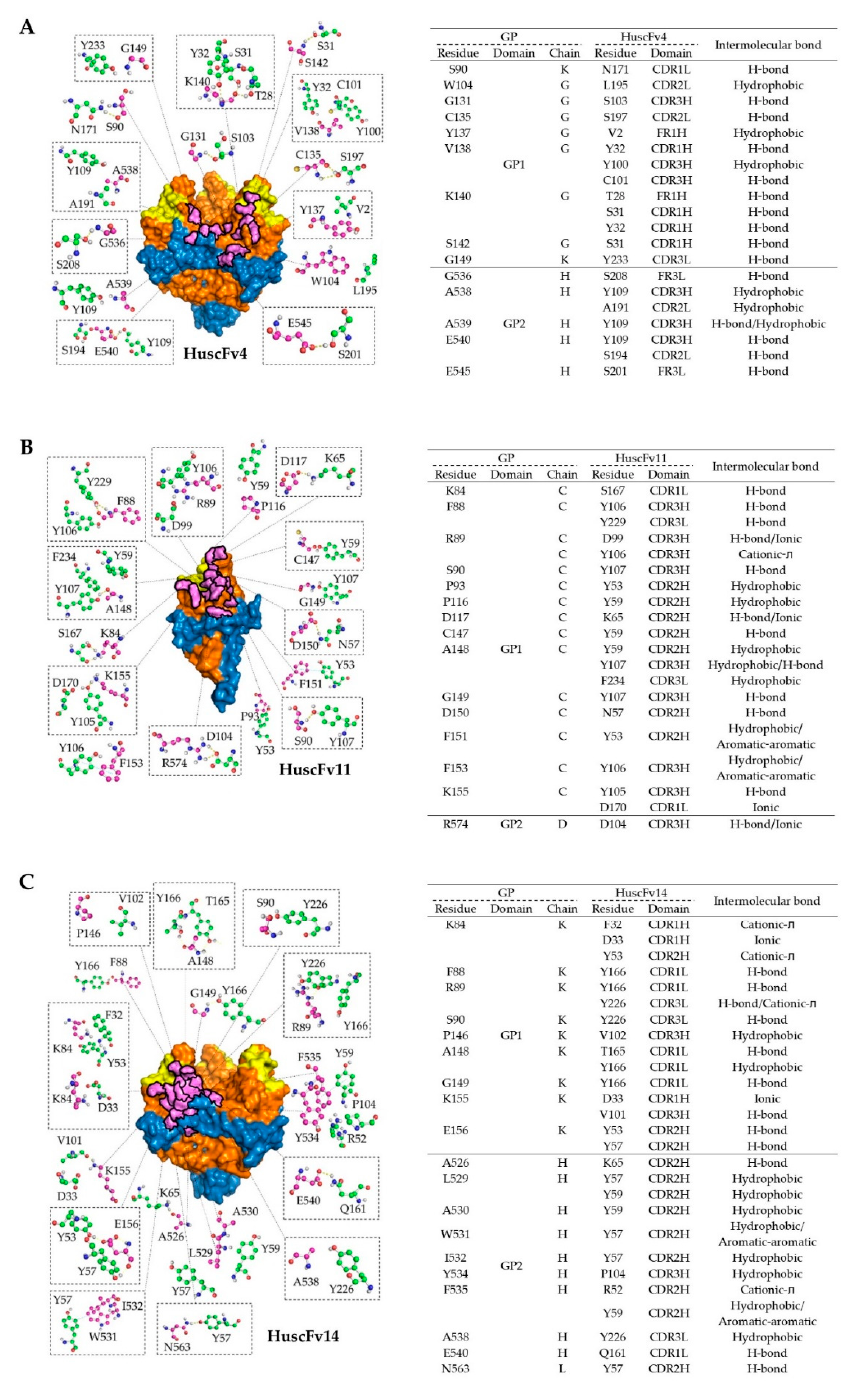
Figure 6. Intermolecular docking-guided presumptive interaction of GPcl residues with HuscFvs. ( A – C ) Ball-and-stick models showing presumptive interaction of HuscFv4 ( A ), HuscFv11 ( B ), and HuscFv14 ( C ), with residues of trimeric GPcl or monomeric GPcl as determined by computerized homology modeling and intermolecular docking, as described in Figure 5B. The amino acid backbones and side chains of GPcl (purple) and HuscFvs (green) are shown. GP1, GP2, and RBS of the GPcl and contact surface areas between the HuscFvs and the GPcl are colored as described in Figure 5B. Tables at the right of each respective figures indicate the detailed residues and domains of GPcl and HuscFvs that formed the contact interface.